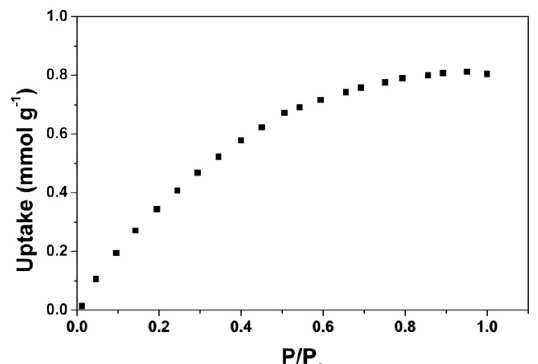
Figure 9. The CO 2 adsorption isotherm of the cryogel obtained from carboxylation and further modification with EDA of the higher degree GO, at 298 K.